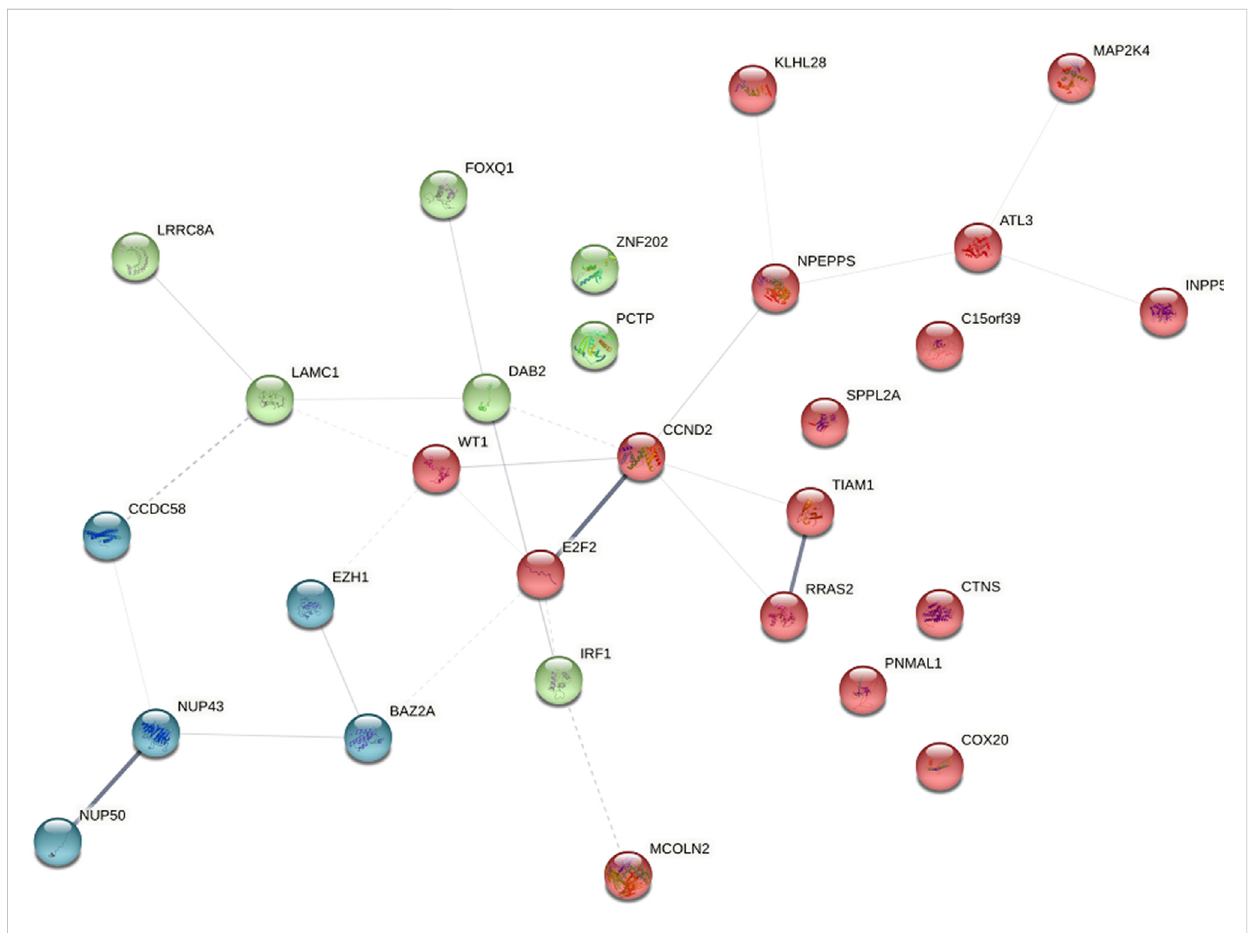
FIGURE 5 Key gene protein interaction (PPI) network.